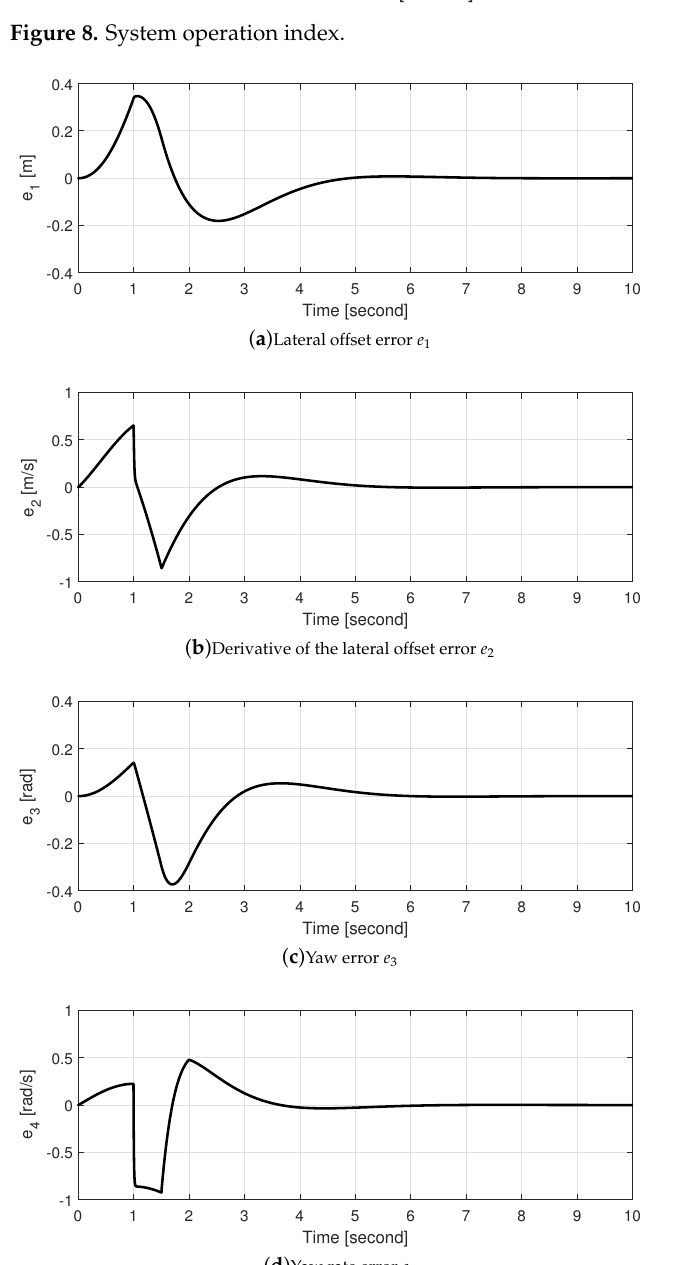
Figure 9. Lateral offset and yaw errors